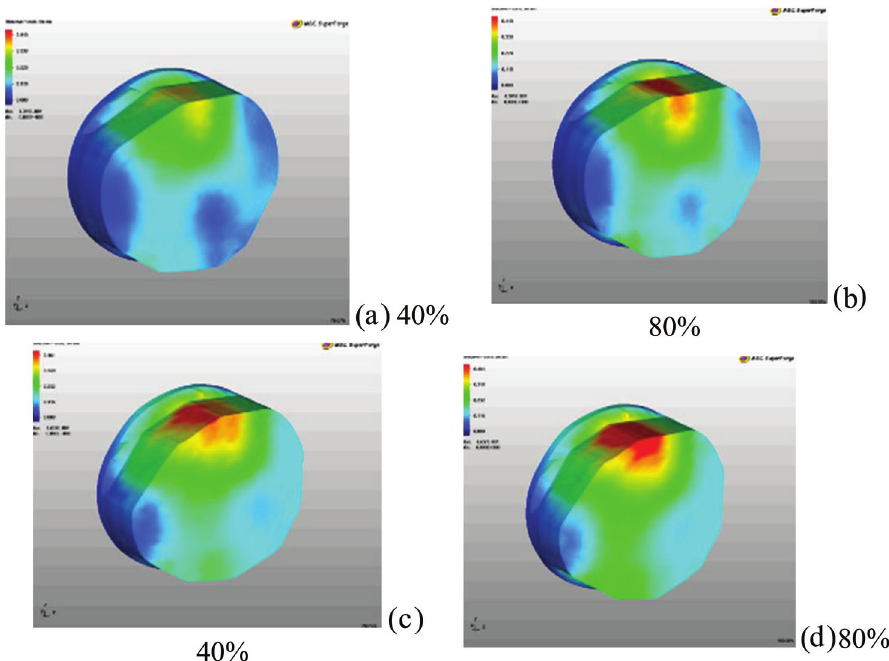
Figure 2: Picture of deformation intensity distribution when forging in the combined baizes with angles of rotation 30° (a and b) and 60° (c and d), t ¼